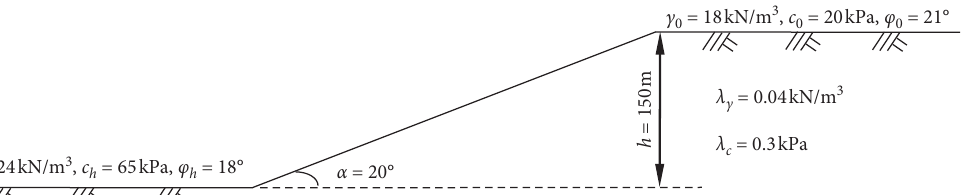
Figure 4: Slope shape and mechanical parameter change law.